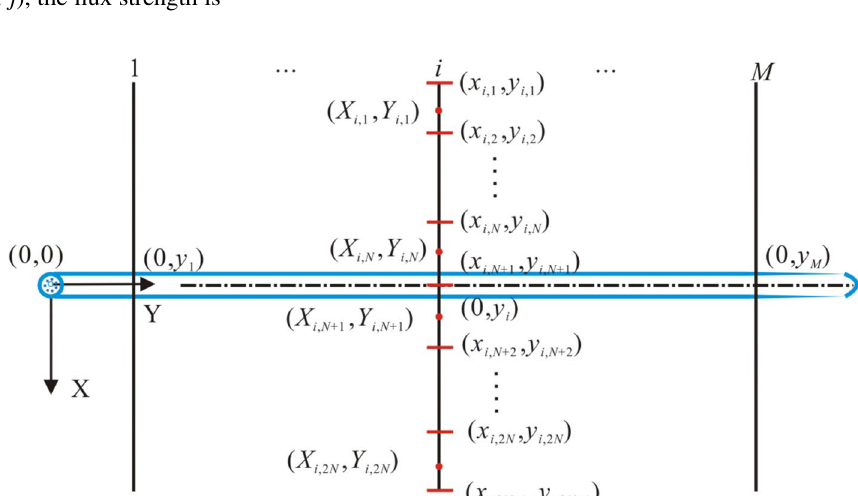
Fig. 3 Description of fracture discrete